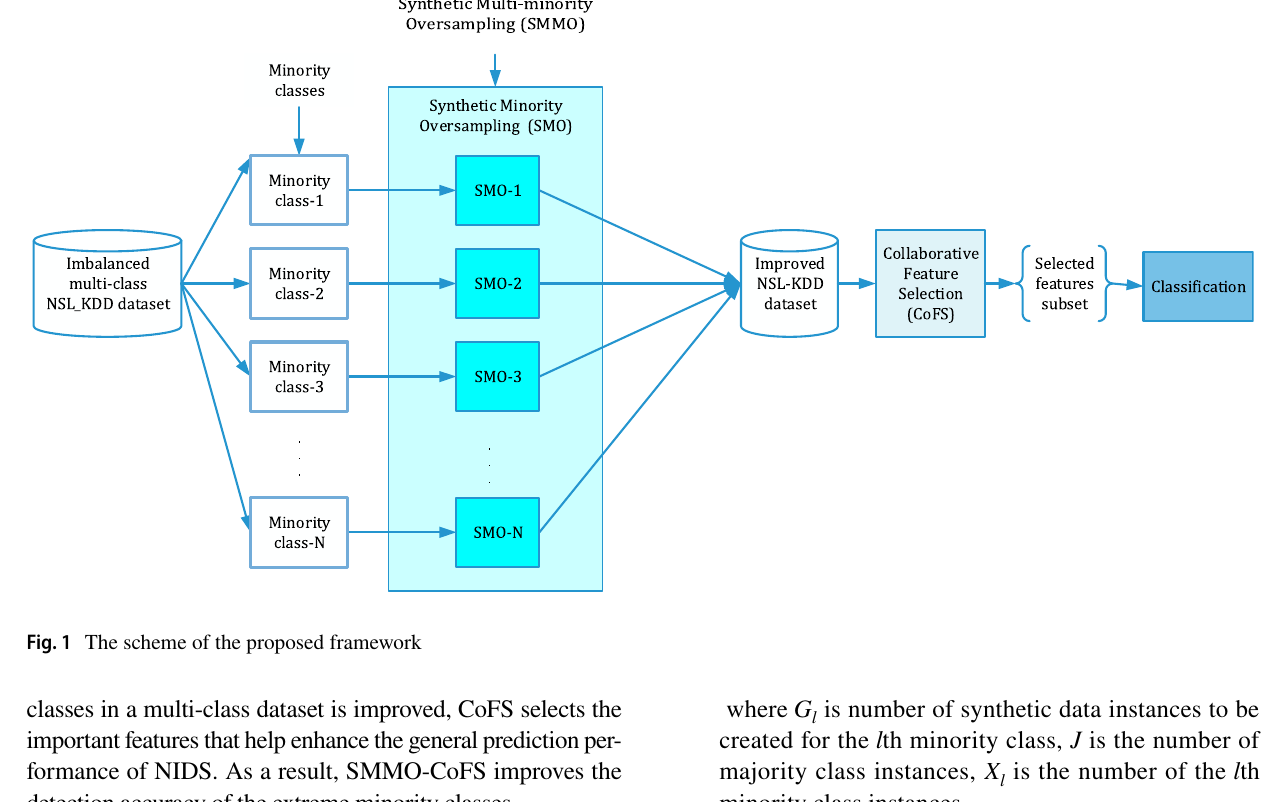
Fig. 1 The scheme of the proposed